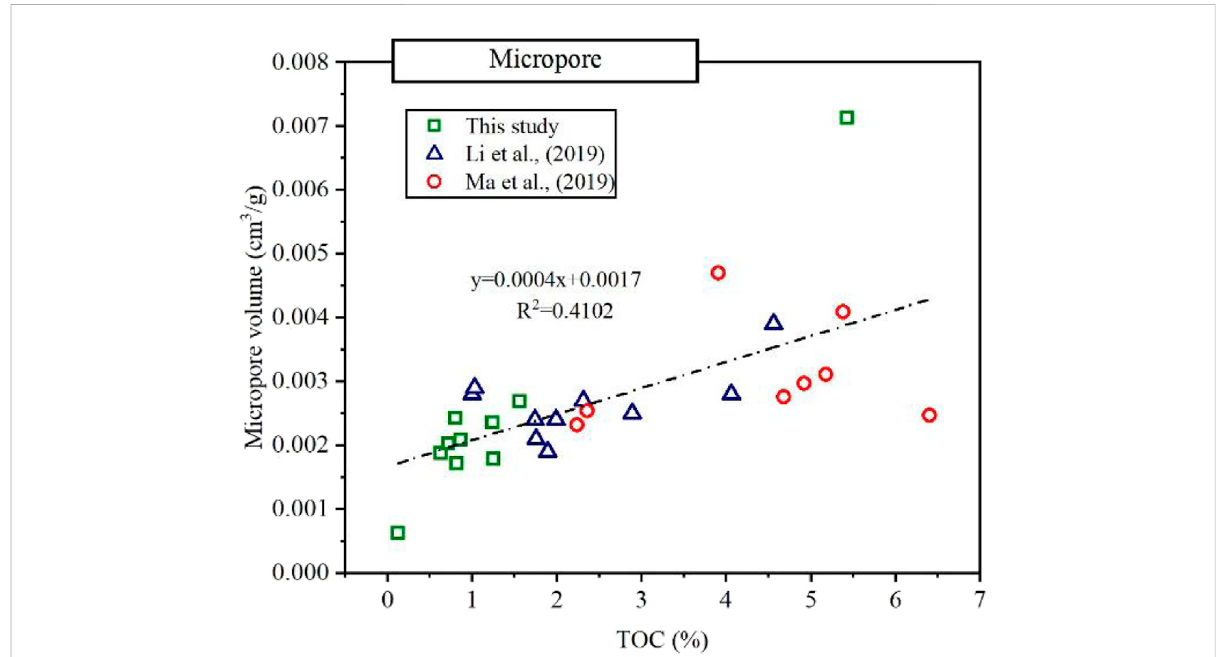
FIGURE 7 Relationship between TOC content and micropore pore volume in different marine-continental transitional shales. Notes: The blue dots are from the shale of the Shanxi Formation in the Linxing area of the Ordos Basin. Mature-high maturity shale. The clay minerals are mainly kaolinite (average31%)(YongLietal.,2019).ThereddotsarefromtheLongtanFormation shaleinGuizhouProvince,which hasawiderangeofmaturity(R o is distributed between 0.86 and 2.04%). The clay minerals are mainly illite/smectite mixed layer (34% on average) (Ma et al.,